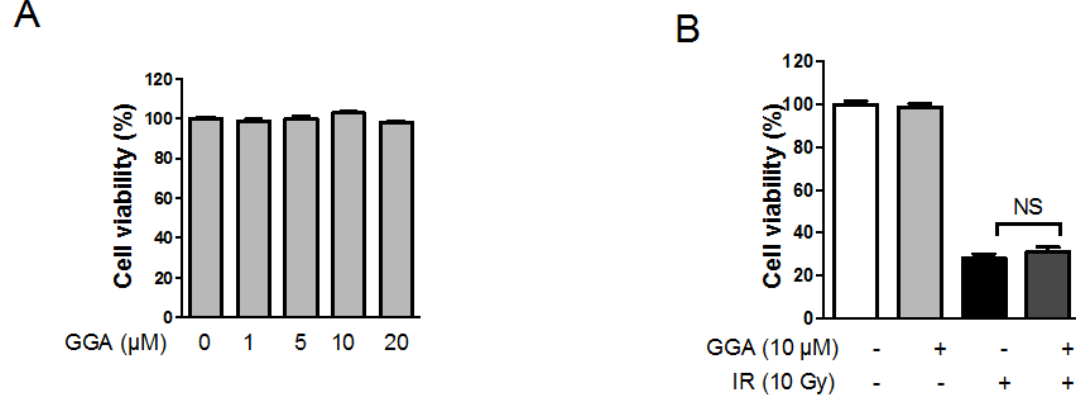
Figure 3. Effects of GGA on endothelial cell viability. ( A ) A cell viability assay was performed on 1 × 10 3 human umbilical vein endothelial cells (HUVECs) that were seeded onto 96-well plates